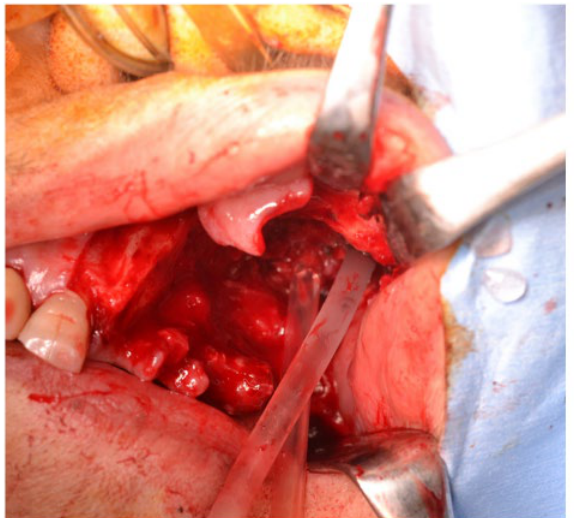
Table 2. Procedures for maxillary sinus.